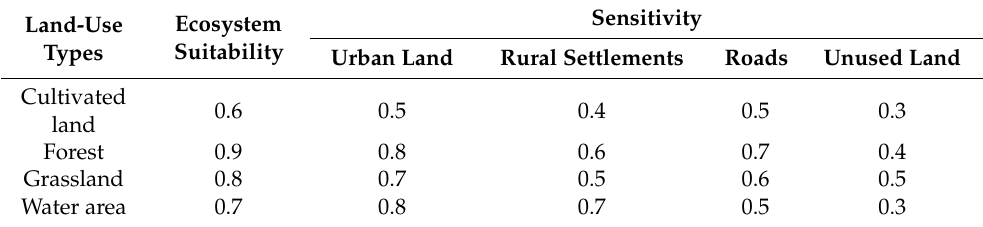
Table 1. Ecosystem suitability and susceptibility of land types to threats.